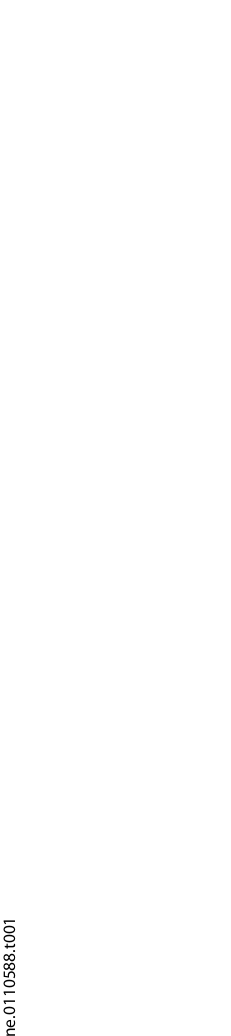
upper row, an extended edematous region is visible. Both types of GB present compartments of soft properties with distinct dissipative behavior. While the soft GB compartment in patient # 15 has low Q values, the soft GB region in # 14 presents with higher dissipative properties, indicating necrotic liquefaction (yellow arrows). The heterogeneity of mechanical tissue properties is further reflected by group-averaged values given for GB, HAM, perifocal region, edema, and contralateral healthy reference tissue in Table 2. Intrinsic tumor heterogeneity is indicated by the standard deviation values for |G*| and Q within the tumor regions. The mean |G*| value for all tumors was 1.32 6 0.26 kPa ranging, from 0.85 kPa (softest tumor) to 1.83 kPa (stiffest tumor). On average, healthy tissue was significantly stiffer than GB with a mean value of 1.54 6 0.27 kPa and a range of 0.99–2.08 kPa (P= 0.001); however, in a group of 5 tumors, higher |G*| values compared to reference tissue were observed (P= 0.015). Mean Q was 0.37 6 0.08 for the tumor tissue and 0.58 6 0.07 for the corresponding healthy tissue. Interestingly, this reduction in Q was seen in all tumors (P= 2.9 6 10 2 10 ) regardless of their |G*| values, which suggests less dissipative (viscous) GB properties compared to healthy tissue. Within the tumor, homogenous appearing matter showed a higher |G*| compared to full GB regions (P= 0.012) without different appearance to healthy tissue (P= 0.228), suggesting that HAM consists of less affected tissue than the remaining GB. Nevertheless, Q HAM was still lower than Q healthy (P= 0.00013) without significant difference to Q tumor (P= 0.40). This high sensitivity of Q to GB is further represented by the normalized ratios Q tumor / Q healthy which are below 1 in all patients indicating the viability of Q as diagnostic biomarker. Figure 3 shows |G*| and Q values of all tumors normalized by healthy tissue parameters ( |G*| GB / |G*| ref and Q GB / Q ref ). This figure illustrates the softer tissue properties in the majority of GB and less dissipative (more elastic) properties in all tumors studied. Additionally, lines of standard deviations are shown for the two tumors displayed in figure 2 (patients # 14 und # 15) in order to indicate the heterogeneity of values encountered within tumor regions. Intriguingly, standard deviations of |G*| GB / |G*| ref do not overlap in both cases, which corroborates the visual appearance of their distinct mechanical tumor properties in Figure 2. No correlation between tumor size and |G*| or phase angle Q was seen with correlation coefficients of R= 2 0.391 (P= 0.072) and R= 0.101 (P= 0.655), respectively. A correlation between the viscoelastic tissue parameters ( |G*| , Q ) and morphological tumor staging (Table 1) was also not seen (R = 2 0.235, P= 0.292 and R = 2 0.063, P =0.781 respectively). |G*| in the perifocal region was not significantly different to |G*| in GB (P= 0.306), whereas Q showed a significant increase in the perifocal region (P= 0.01). The significant correlation between |G*| of tumor and perifocal region (R = 0.571, P= 0.0055) indicates the extension of the tumor’s viscoelastic properties into surrounding tissue. In 16 of 22 GB included in this study, perifocal edema was visible in T2w MRI and could be outlined for MRE parameter analysis. On average, edema tissue was significantly stiffer than GB (P= 0.004), whereas Q was not significantly altered between tumor and edema (P =0.99). No correlation between |G*| of tumor and edema was observed (R= 0.34, P= 0.197). Lower values for |G*| healthy at 1.5T (1.36 6 0.21 kPa) than at 3T field strength (1.71 6 0.22 kPa, P= 0.001) were observed, while none of the other parameters given in Table 2 was significantly different between 3T and 1.5T. Specifically, three of the five cases